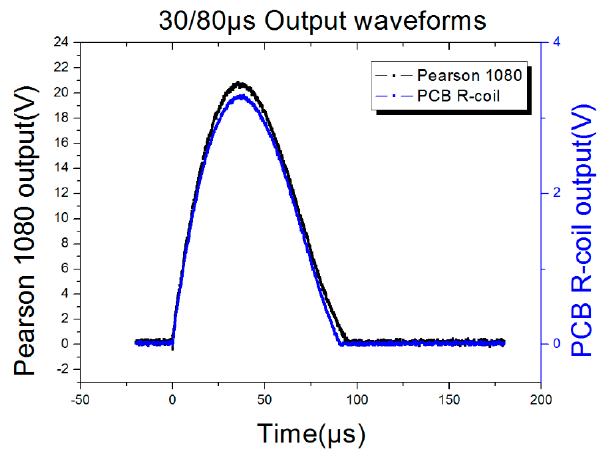
Figure 17. 30/80 impulse current output waveforms.